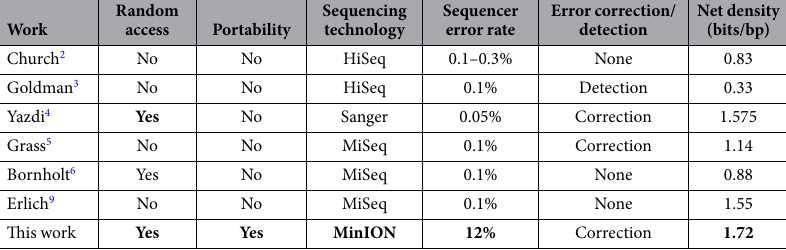
Table 1. Comparison of features/properties of current DNA-based storage